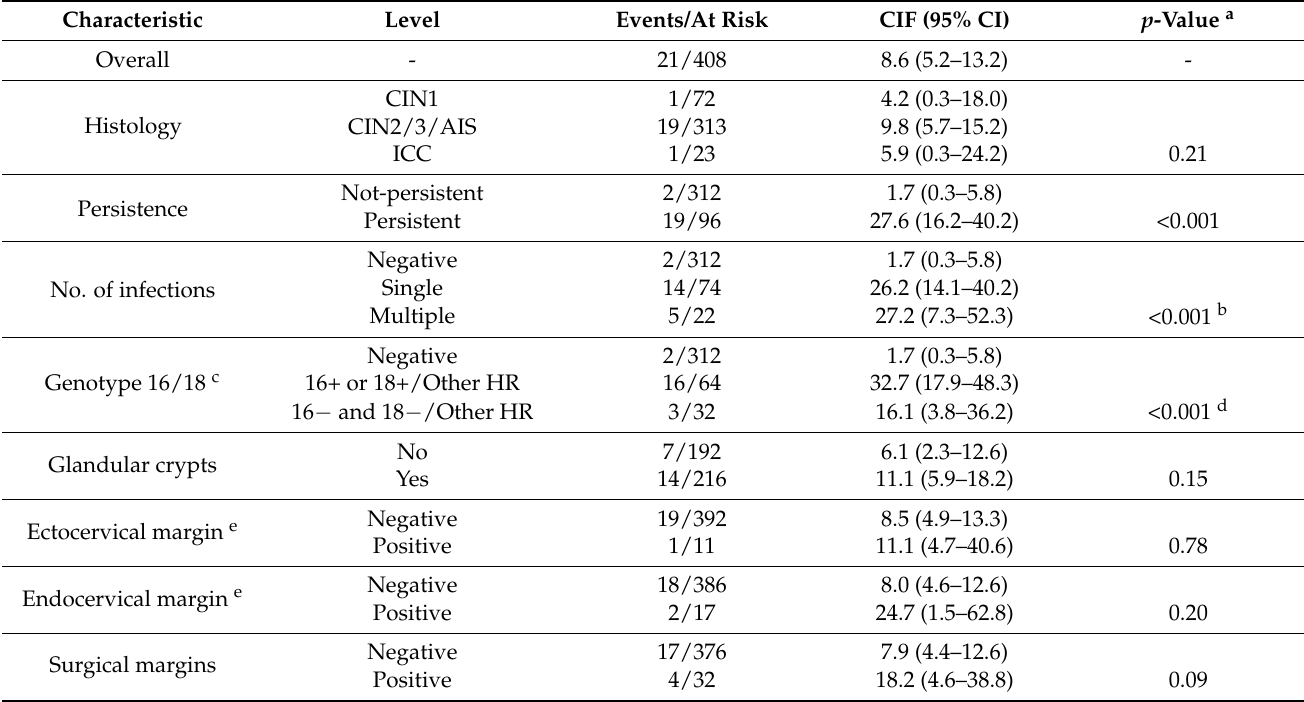
Table 3. Cumulative Relapse Incidence Functions (CIF) at 2 years by infection status at 3–9 months from baseline and